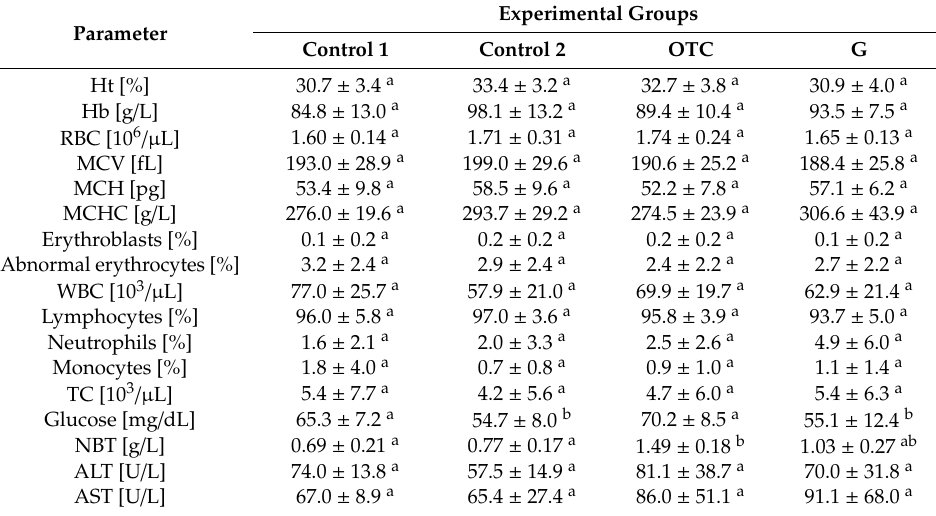
Table 1. The e ff ects of oxytetracycline and gentamicin on the hematological and biochemical parameters in common carp (Control 1—untreated, Control 2—injected with 0.6% NaCl, OTC—fed oxytetracycline 4 times every 2 days at 75 mg / kg, G—injected with single dose 50 mg / kg gentamicin in 0.6% NaCl, di ff erent letter superscripts indicate statistically significant di ff erences among groups, n = 10, Duncan post-hoc test, p ≤ 0.05).